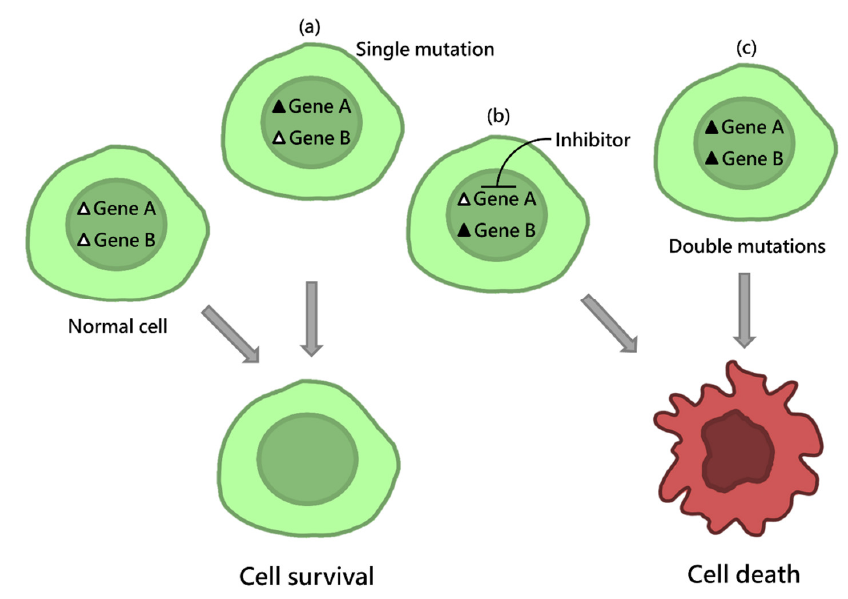
Figure 1. A graphic illustration of synthetic lethality. ( a , c ) Gene A and gene B are synthetic lethal when simultaneous mutation of gene A and B leads to cell death, but a single mutation of either does not. ( b ) The SL concept can be exploited to inhibit the SL partner (Gene A) of a mutant Gene B in a tumor cell.